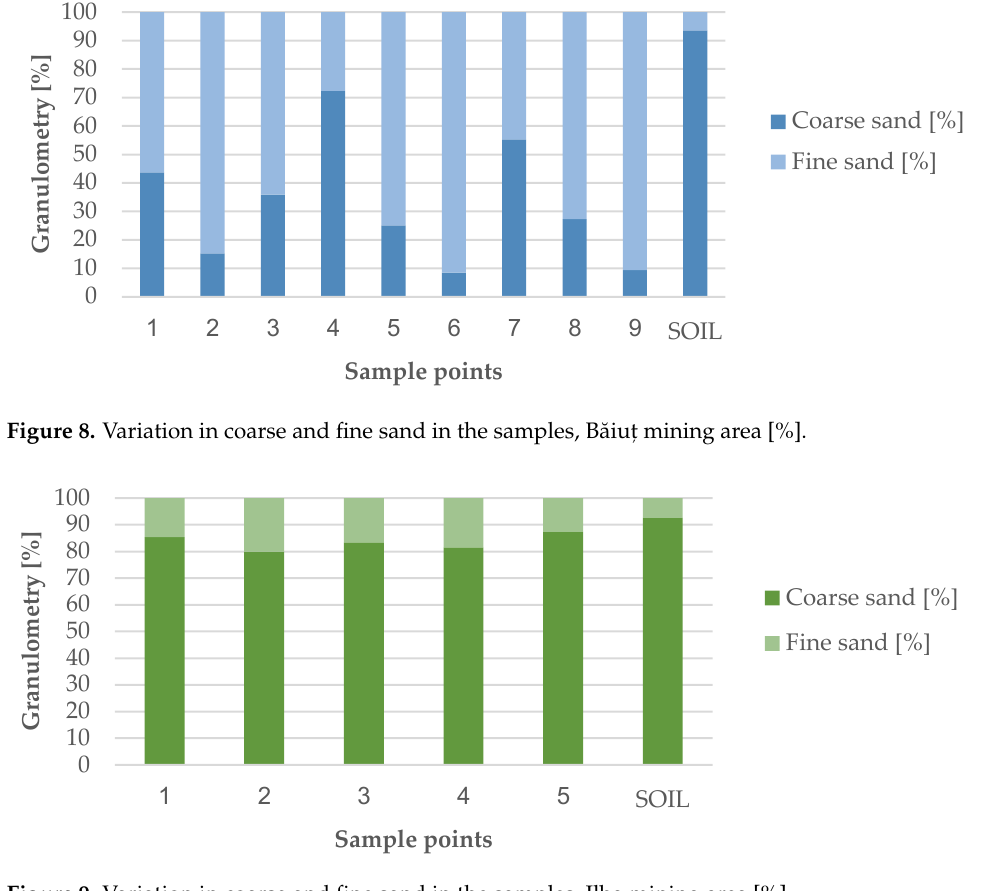
Figure 9. Variation in coarse and fine sand in the samples, Ilba mining area [%]. According to the measured pH values in the studied areas, it was found that the pre- dominant pH in both sterile dumps is highly acidic (≤3.5). The soil from the Băiut area is highly acidic, while it is moderately acidic in the Ilba area (5.1 – 5.4). The average pH at each point in the sterile samples for the studied areas is presented in Figures 10 and 11.